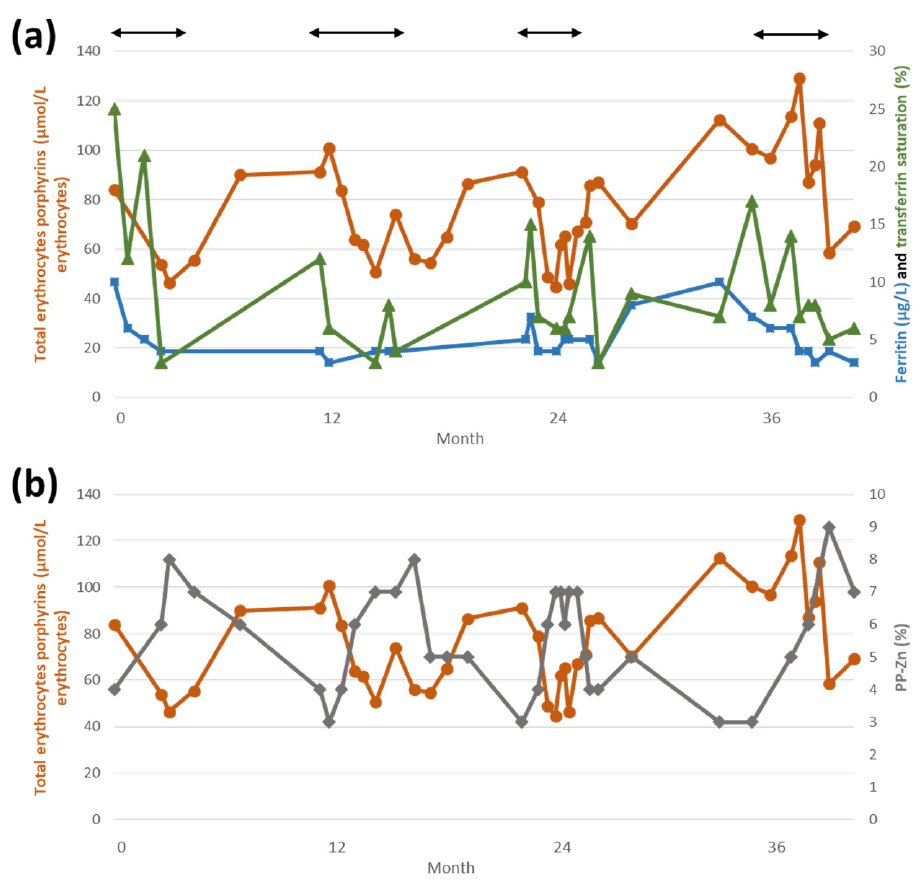
Figure 2. EPP patient’s biological parameters. Black arrows indicate treatment periods. ( a ) Total erythrocytes porphyrins ( µ mol/L erythrocytes, dots), ferritin ( µ g/L, squares) and transferrin saturation (%, triangles); ( b ) total erythrocytes porphyrins ( µ mol/L erythrocytes, dots) and PP-Zn (protoporphyrin-Zn, %, diamonds). EPP: erythropoietic protoporphyria.